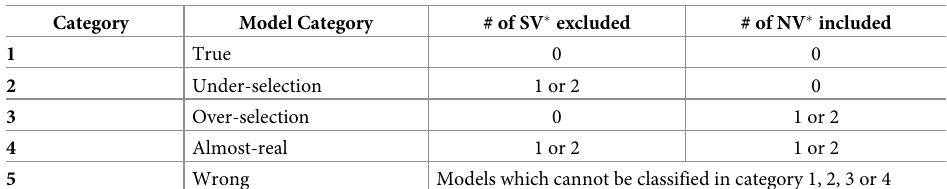
Table 2. Classification of selected models for 15 covariates (Taken from [24]). Category Model Category # of SV � excluded # of NV � included True 0 0 2 Under-selection 1 or 2 0 3 Over-selection 0 1 or 2 4 Almost-real 1 or 2 1 or 2 5 Wrong Models which cannot be classified in category 1, 2, 3 or 4 � SV and NV denote signal and noise variables,